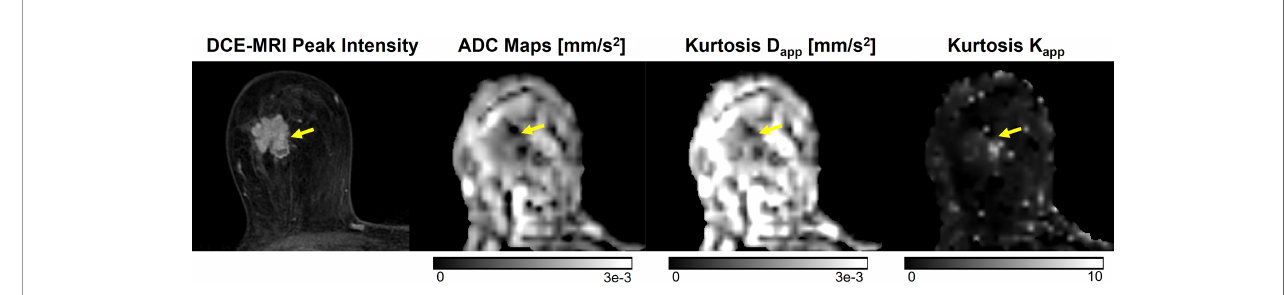
FIGURE 7 | Example of DKI analysis using b-values of 0, 500, 1000, and 2000 s/mm 2 , compared to conventional ADC images using b-values of 0 and 1000 s/mm 2 and DCE-MRI peak intensity subtraction (1 min 30 s post-contrast). Invasive ductal carcinoma in a 67-year-old patient is indicated by the yellow arrow. The lesion displays higher mean kurtosis (K app ) than surrounding healthy tissue. Images were acquired using a wide-bore 3T scanner, and mean kurtosis and diffusivity (D app ) were calculated as previously